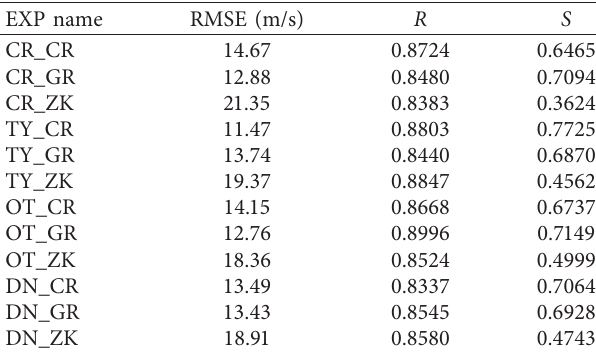
Table 5: Root mean square error (RMSE), Pearson correlation coefficient ( R ), and model skill ( S ) for UMAX from 12